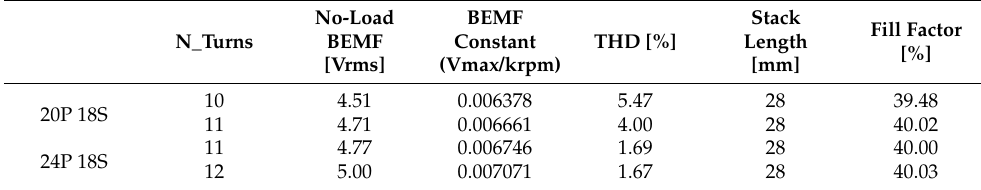
Table 5. Optimal Design Results.